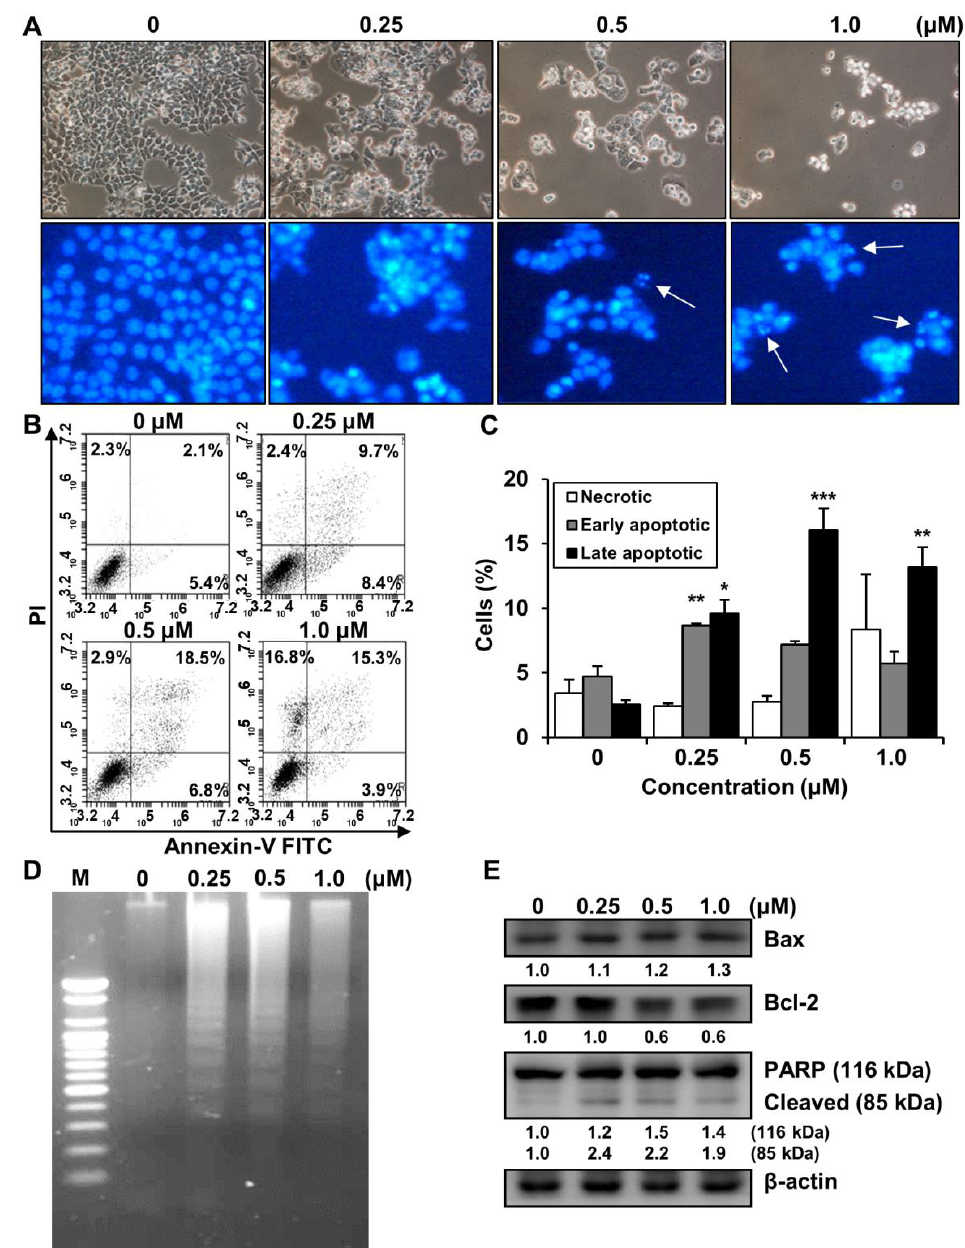
Figure 6. Effect of MHY2245 on the induction of apoptosis in HCT116 cells. ( A ) Morphological changes in MHY2245-treated cells. HCT116 cell nuclei were stained with fluorescent DNA-binding dye (Hoechst 33342). Arrows indicate apoptotic cells ( × 100). ( B ) Effect of MHY2245 on the death of cells stained with Annexin V-FITC/PI and analyzed via flow cytometry. ( C ) Graph showing the effect of MHY2245 on cell death. Results are presented as mean ± SD, n = 3, and are expressed as a percentage of that in vehicle-treated control cells. * p < 0.05, ** p < 0.01, and *** p < 0.001 compared with vehicle-treated control cells. ( D ) Representative results of DNA analyses from three independent experiments are provided. M, marker. ( E ) Effects of MHY2245 on the expression of Bax, Bcl-2, and PARP in HCT116 cells. Western blot analysis of total lysates of cells treated with increasing concentrations of MHY2245. β -actin was used as a loading control. Representative results from three independent experiments are